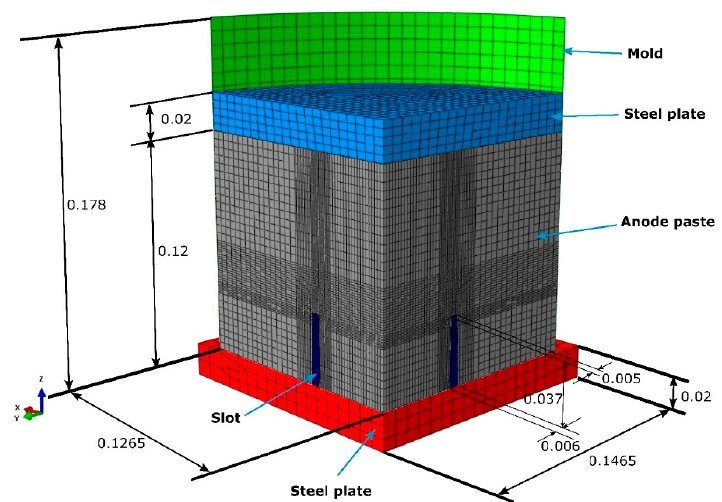
Materials 2019 , 12 , x FOR PEER REVIEW Figure 22. CAD model for the test with the slot (m). Figure 22. CAD model for the test with the slot (m).